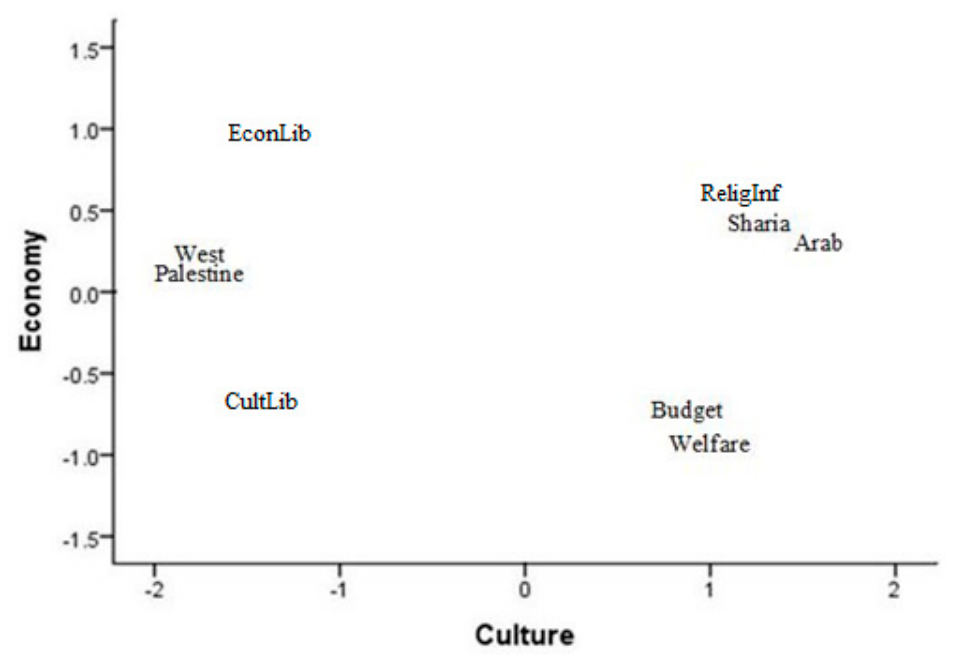
Figure 9. Ideological structure of Egyptian issues,